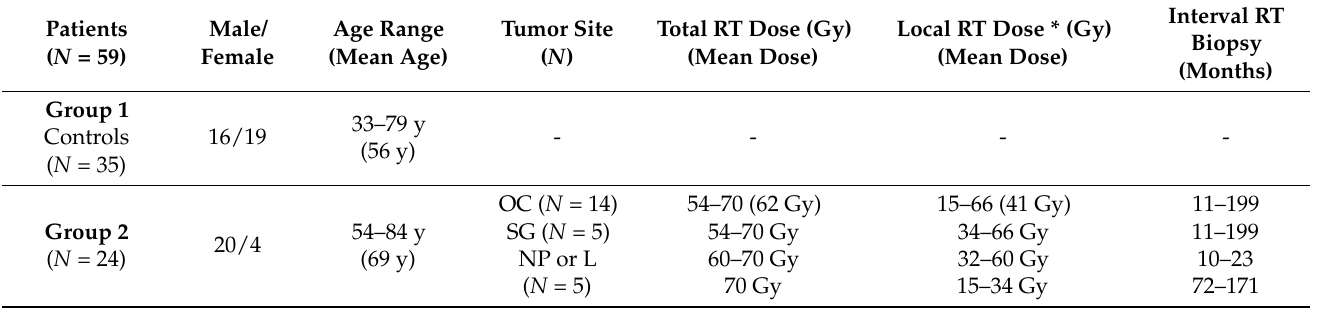
Table 1. Demographics of study patients, tumor site, and treatment